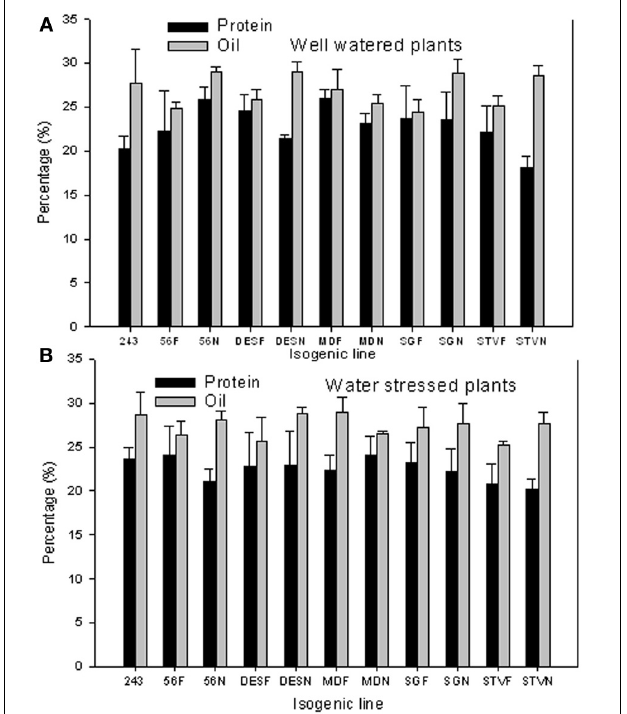
FIGURE 1 | Effect of fuzzless seed trait on seed protein and oil under well-watered (A) and water stressed (B) conditions in near isogenic cotton mutant lines. In each line, F refers to a fuzzy line and N refers to its equivalent fuzzless line. Since the experiment was repeated twice and the results were pooled and combined, bar values are mean of eight replicates ± SE (standard error of the mean).